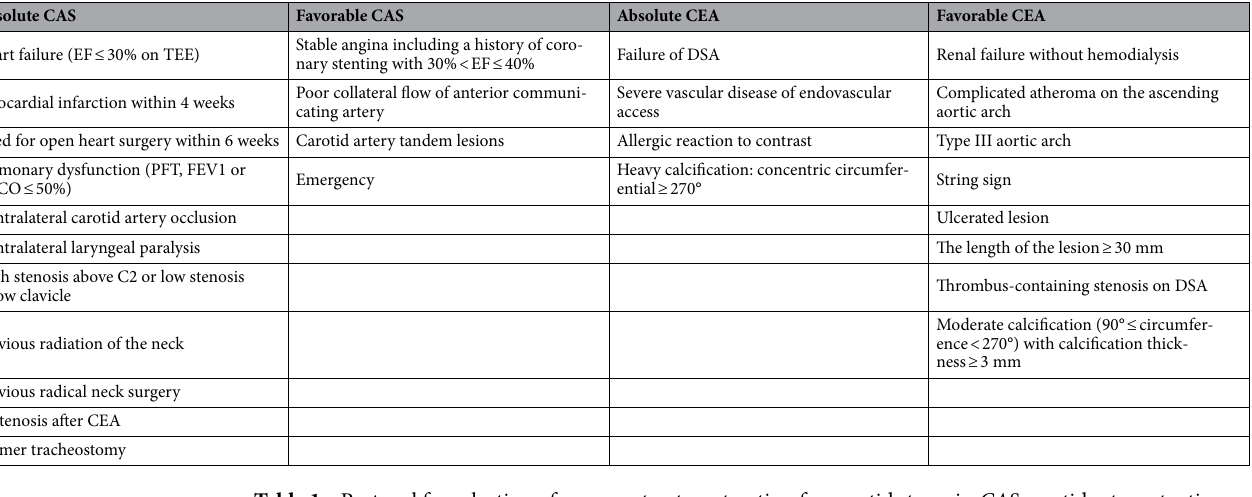
Table 1. Protocol for selection of a proper treatment option for carotid stenosis. CAS carotid artery stenting, CEA carotid endarterectomy, DLCO diffusion capacity of the lung for carbon monoxide, DSA